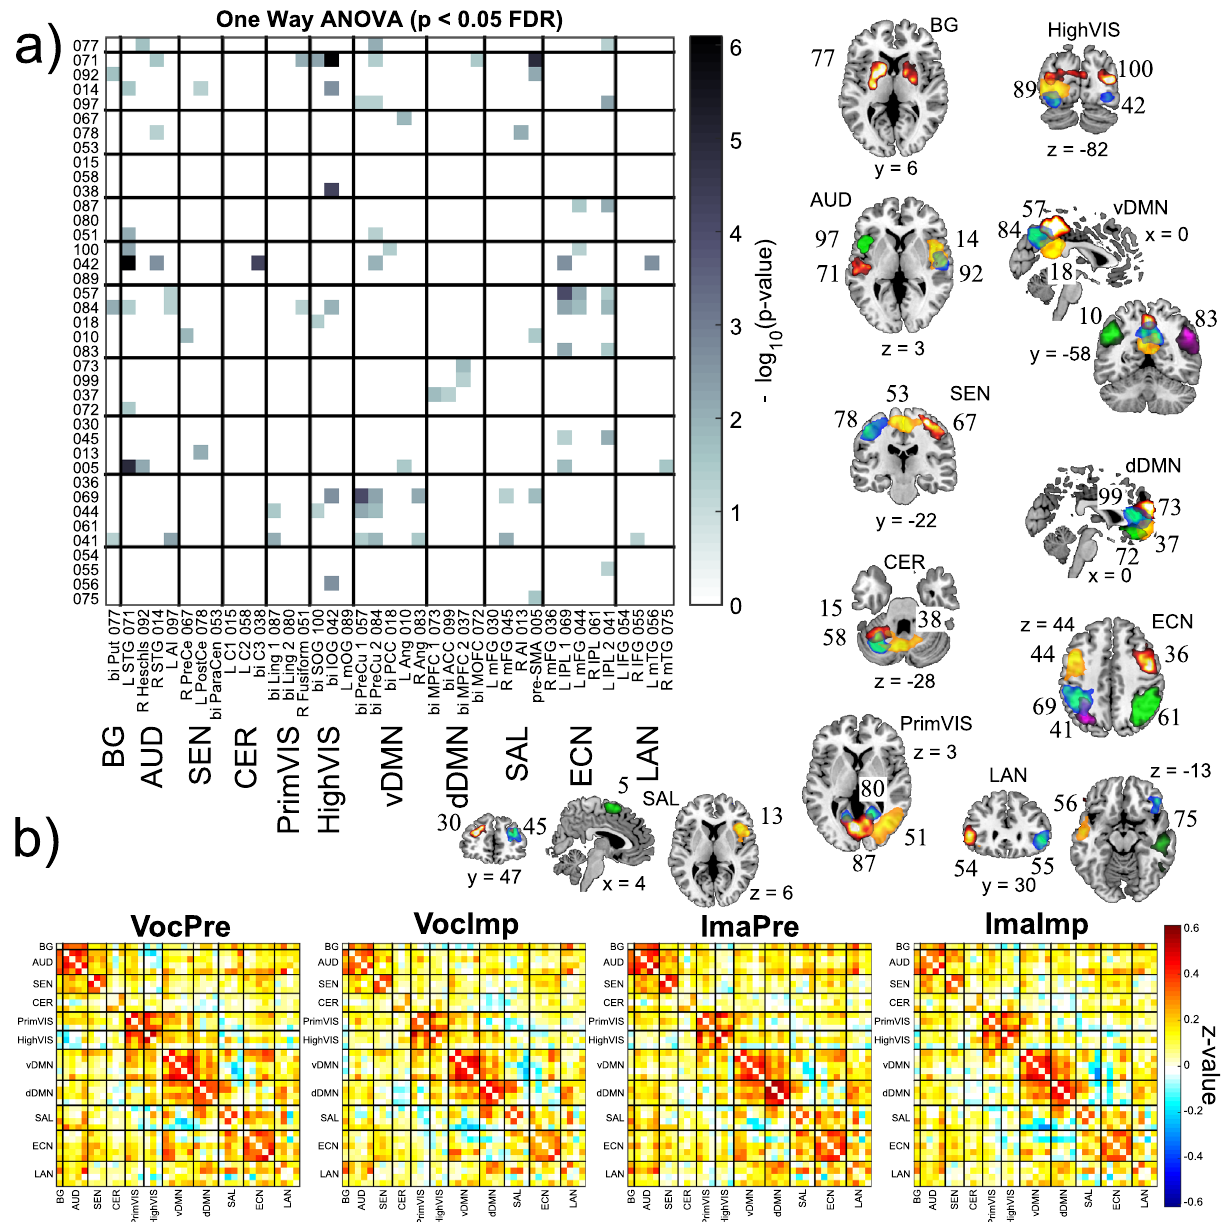
Figure 3. One-Way ANOVA test results considering static FNC of the four tasks: VocPre, VocImp, ImpPre and ImaImp. In ( a ), tests not passing the significance threshold p > 0.05 after FDR correction are represented in white. In ( b ), average FNC matrices for each task are presented. The figure includes spatial maps for each brain region, indicated by indexes for ease of illustration. Spatial maps were plotted using MRICRON (2MAY2016; https:// www. nitrc. org/ proje cts/ mricr on/). The indexes correspond to the gICA